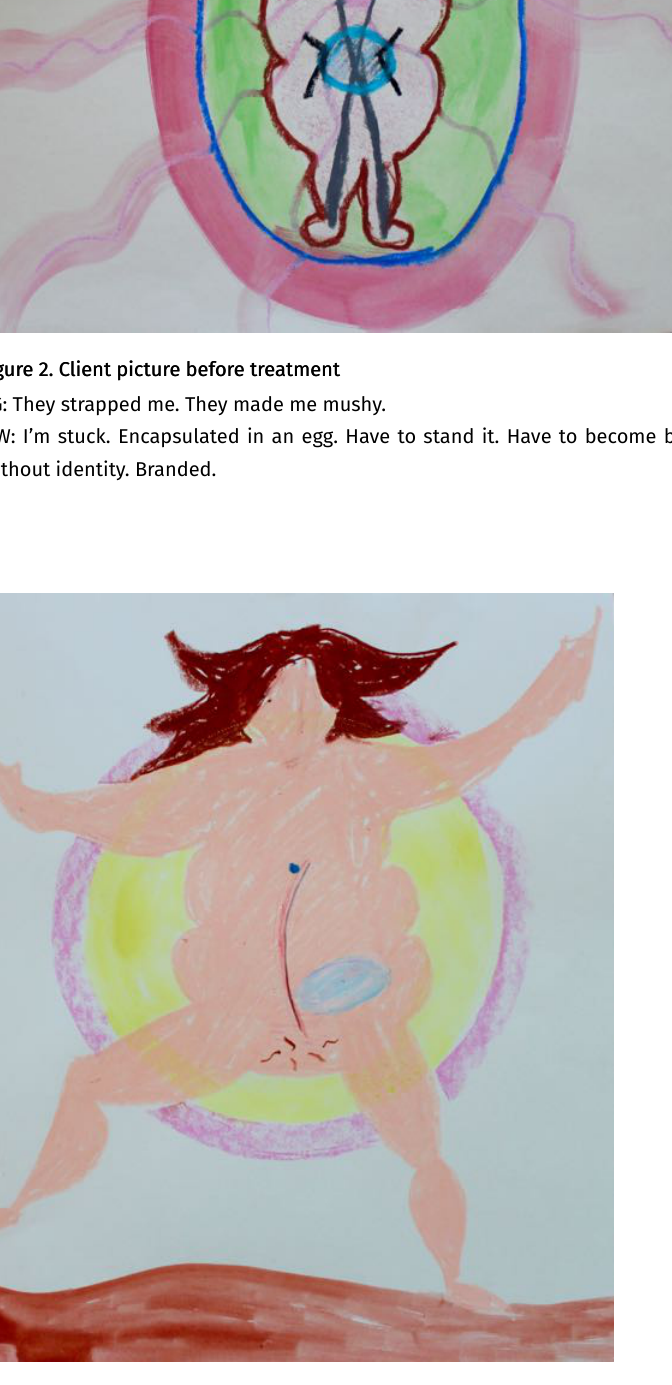
FFigigururee 3.3. CClientlient picturpicturee aftafterer